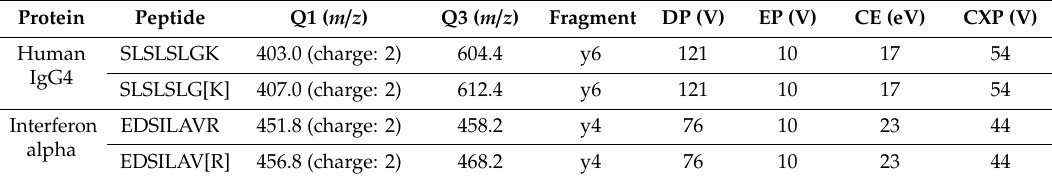
Table 4. The optimized mass transition and condition for multiple reaction monitoring (MRM) analysis for therapeutic fusion proteins